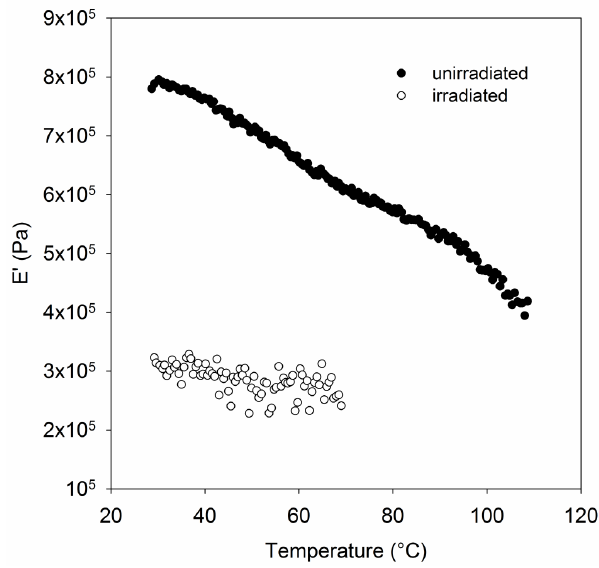
Figure 9. Dynamic mechanical thermal analysis (DMTA) temperature–frequency sweep of irradiated and unirradiated UHMMPE fiber.